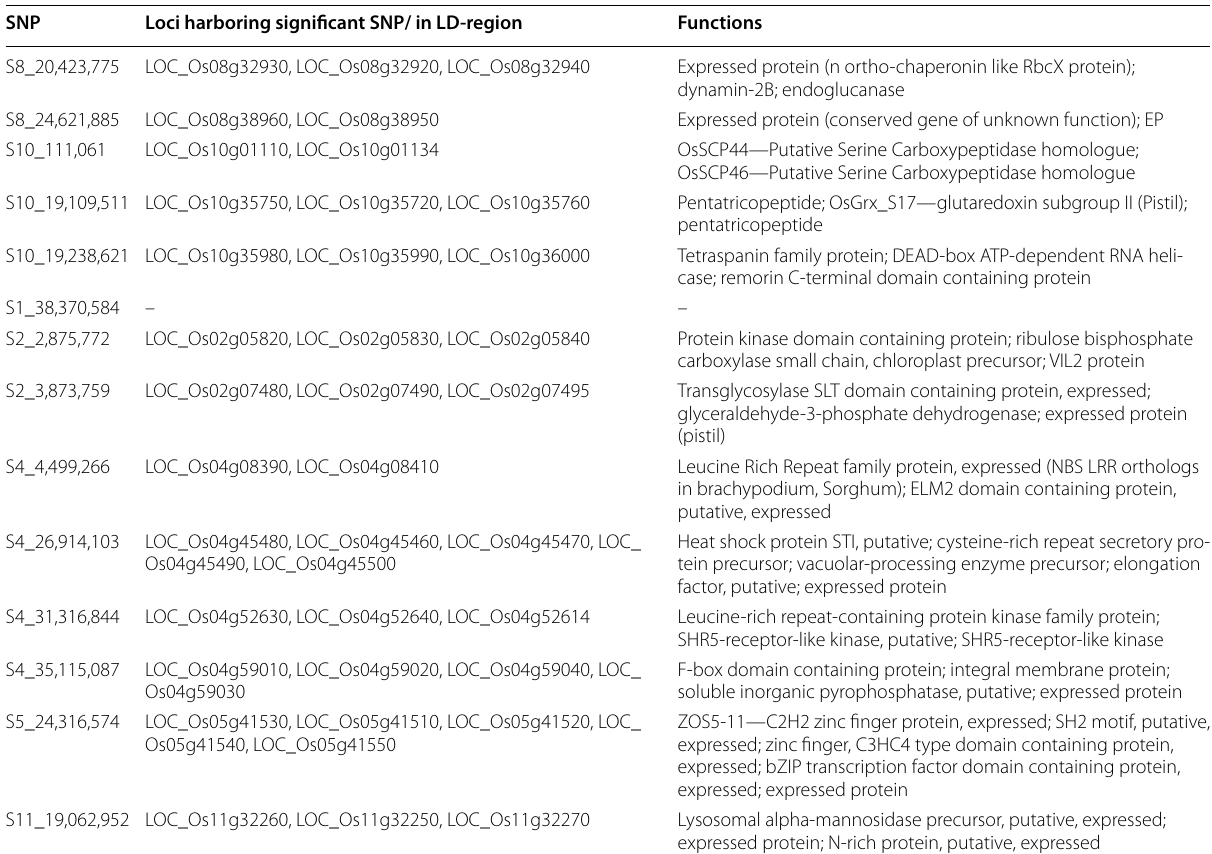
chi-square values along with p -values have been pre- sented in Table 5 and represented via box-plots in Fig. 6a–f. For all the traits, the differences among alleles were statistically significant at 34 genomic